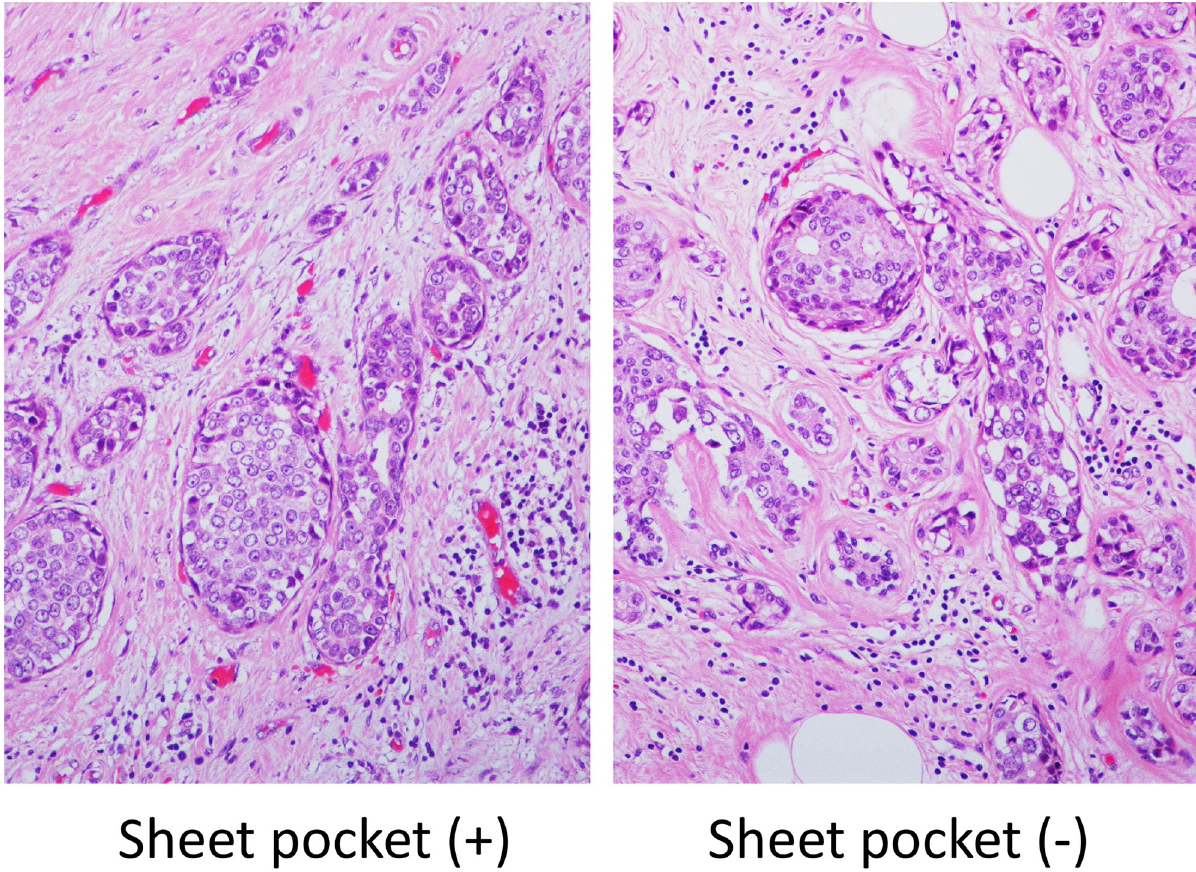
Fig 8. Influence of staining properties of H&E staining tissue specimens. No differences in H&E staining were detected between the blocks using a sheet pocket and those using normal